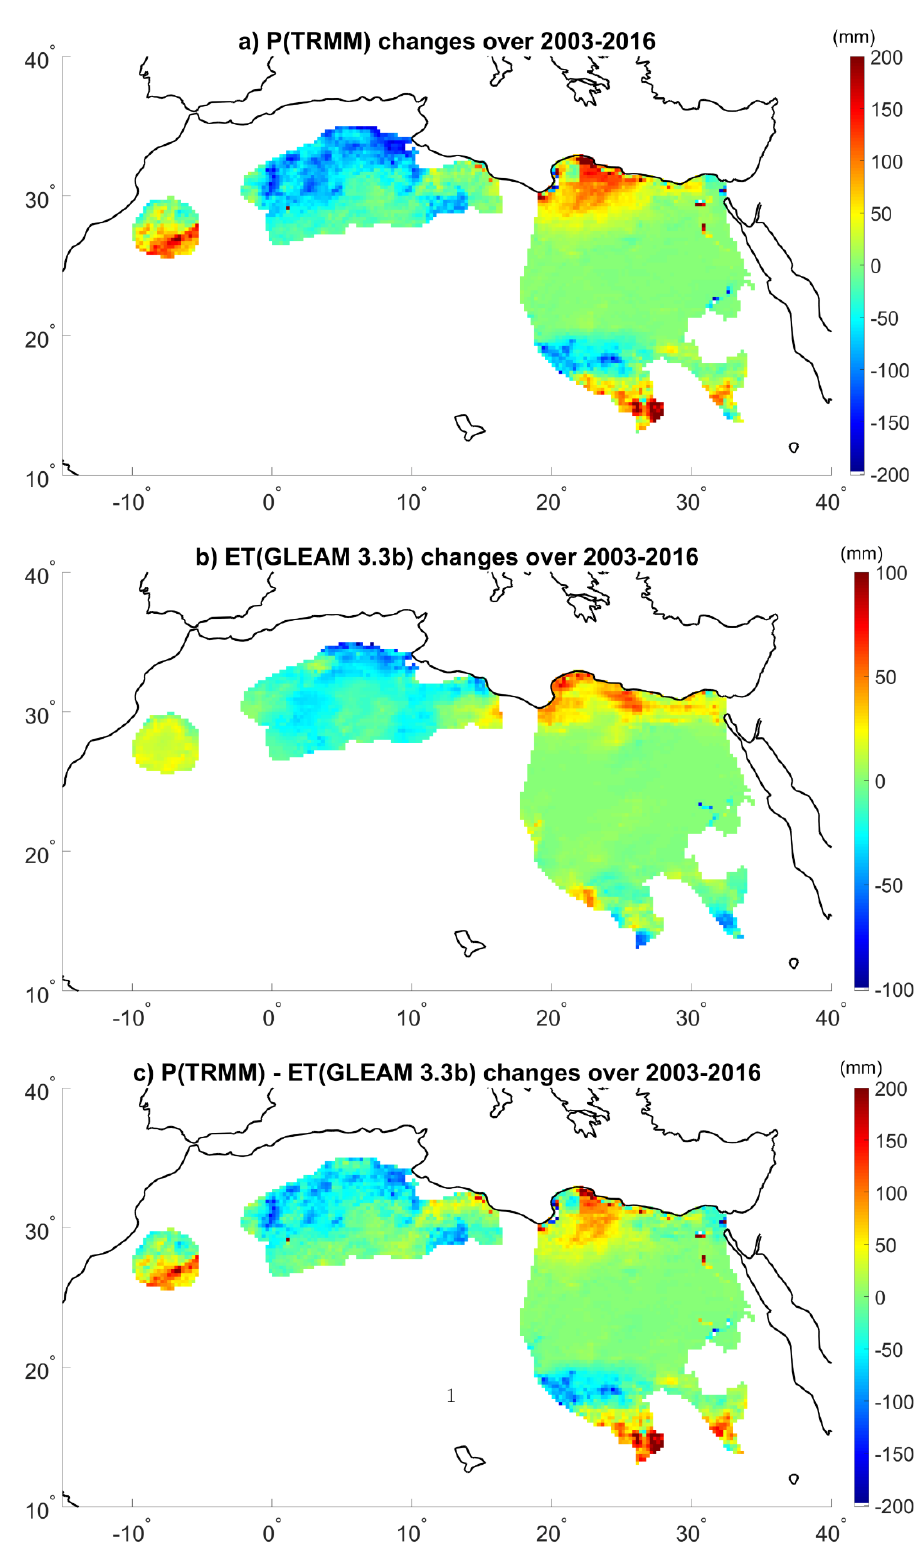
Figure 8. Time series of annual rainfall from TRMM (blue), ET from GLEAM 3.3b (red), P–ET as the difference of the two former (green) between 2003 and 2016 for TAS ( a ); NWSAS ( b ); and NSAS ( c ).